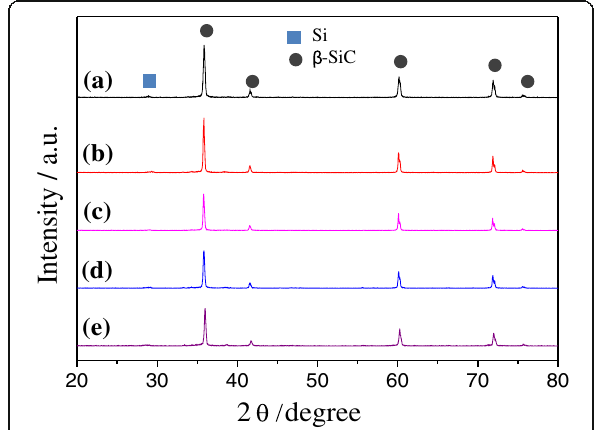
Fig. 6 XRD profiles of SiC pellets sintered with nano-sized Si-SiC composite particles and activated carbon by SPS process (details of a, b, c, d, and e are given in Table 2)